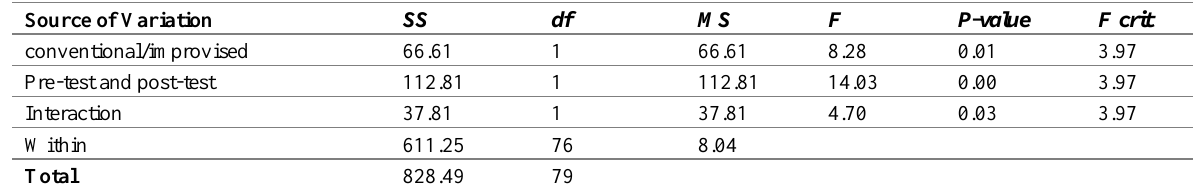
Table 3: ANOVA Two Factor Analysis